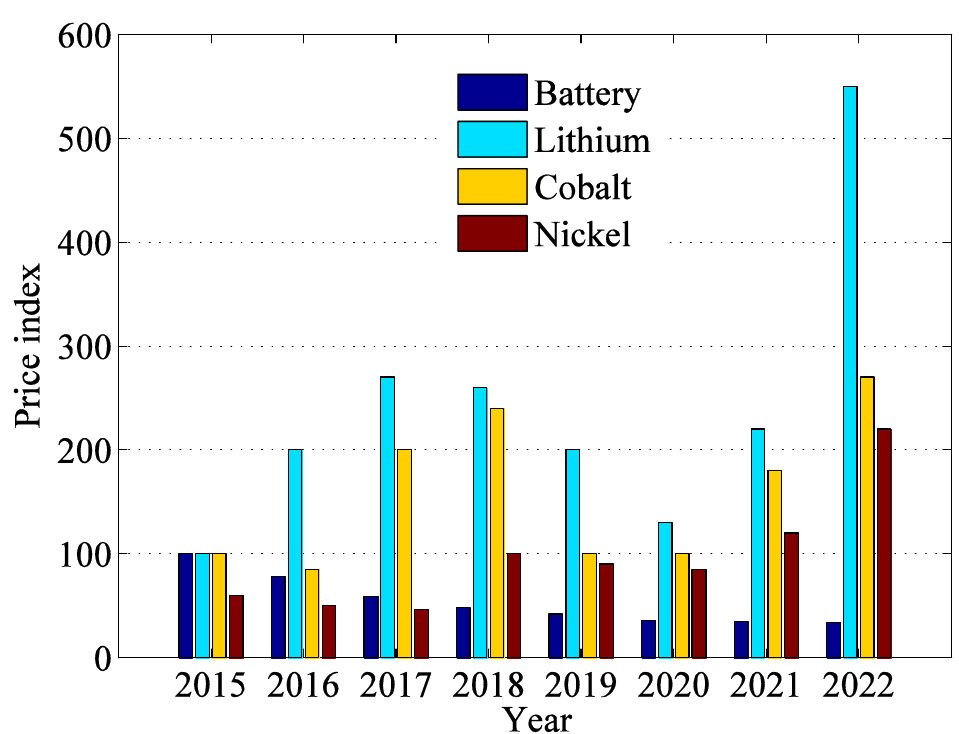
Figure 7. Battery metal price appreciation and battery price depreciation over the last eight years [4,43].